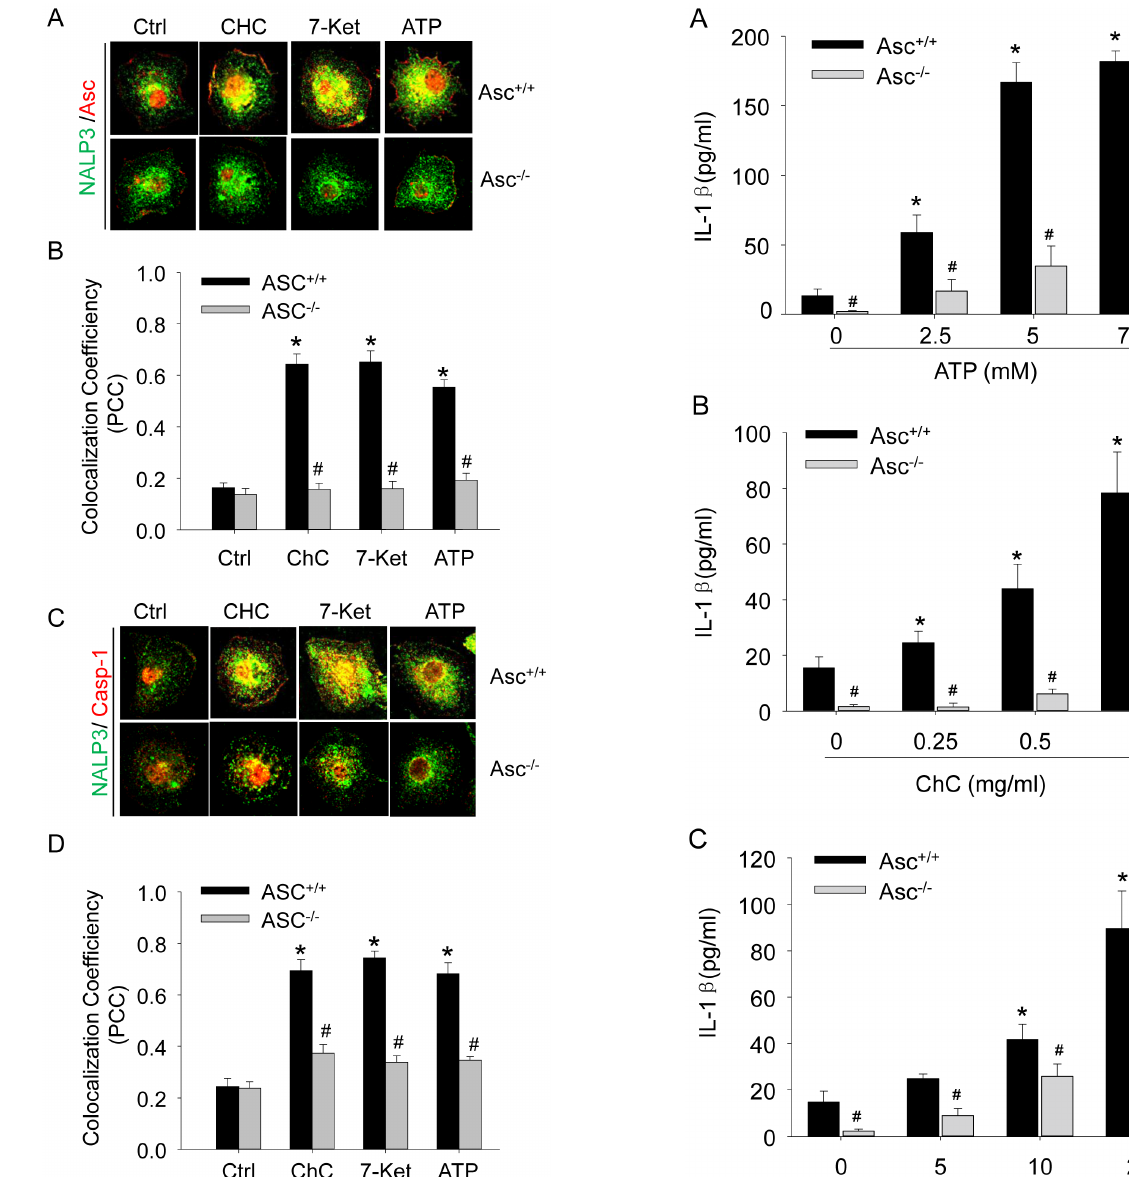
Figure 2. Effects of ATP, cholesterol crystals and 7-Ketocho- lesterol on Nlrp3 inflammasome formation in Asc + / + and Asc 2 / 2 BMMs. (A) Representative confocal fluorescence images depicting the effects of cholesterol crystals (CHC, 0.5 mg/ml, 16 h), 7-ketocholesterol (7-Ket, 10 m g/ml, 16 h), or ATP (2.5 mM, 16 h) on the colocalization between Nlrp3 and Asc from Asc + / + and Asc 2 / 2 BMMs. (B) Summarized data showing colocalization efficiency between Nlrp3 and Asc. (C) Representative confocal fluorescence images depicting the effects of cholesterol crystals (CHC, 0.5 mg/ml, 16 h), 7-ketocholesterol (7-Ket, 10 m g/ml, 16 h), or ATP (2.5 mM, 16 h) on the colocalization between Nlrp3 and caspase-1 from Asc + / + and Asc 2 / 2 BMMs. (D) Summarized data showing colocalization efficiency between Nlrp3 and caspase-1. * P , 0.05 vs . untreated Asc + / + control group; # P , 0.05 Asc 2 / 2 vs . Asc + / + group (n=6).